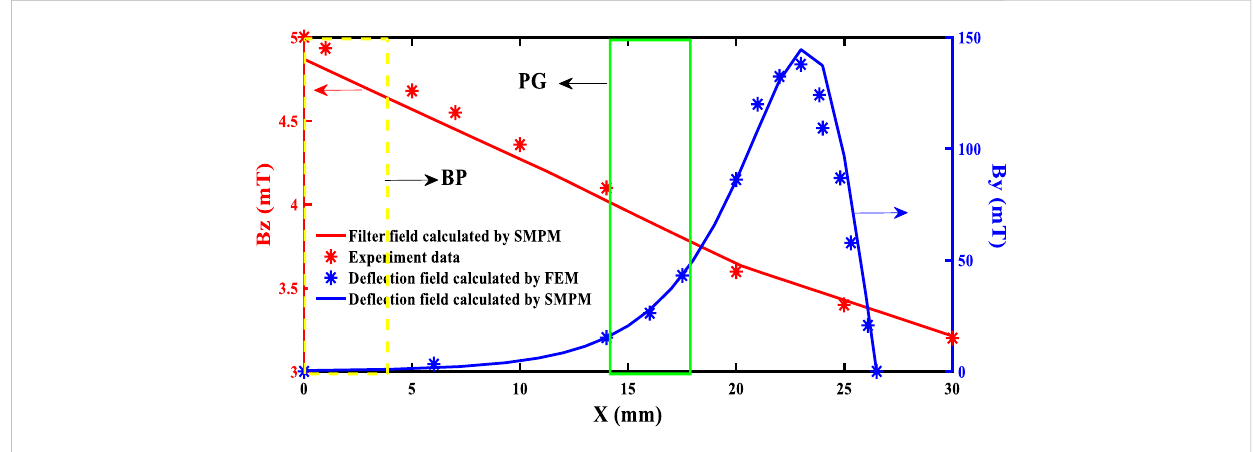
FIGURE 6 The distribution of the long-range weak magnetic fi lter fi eld and the short-range strong magnetic de fl ection fi eld near the PG along the X -axis.